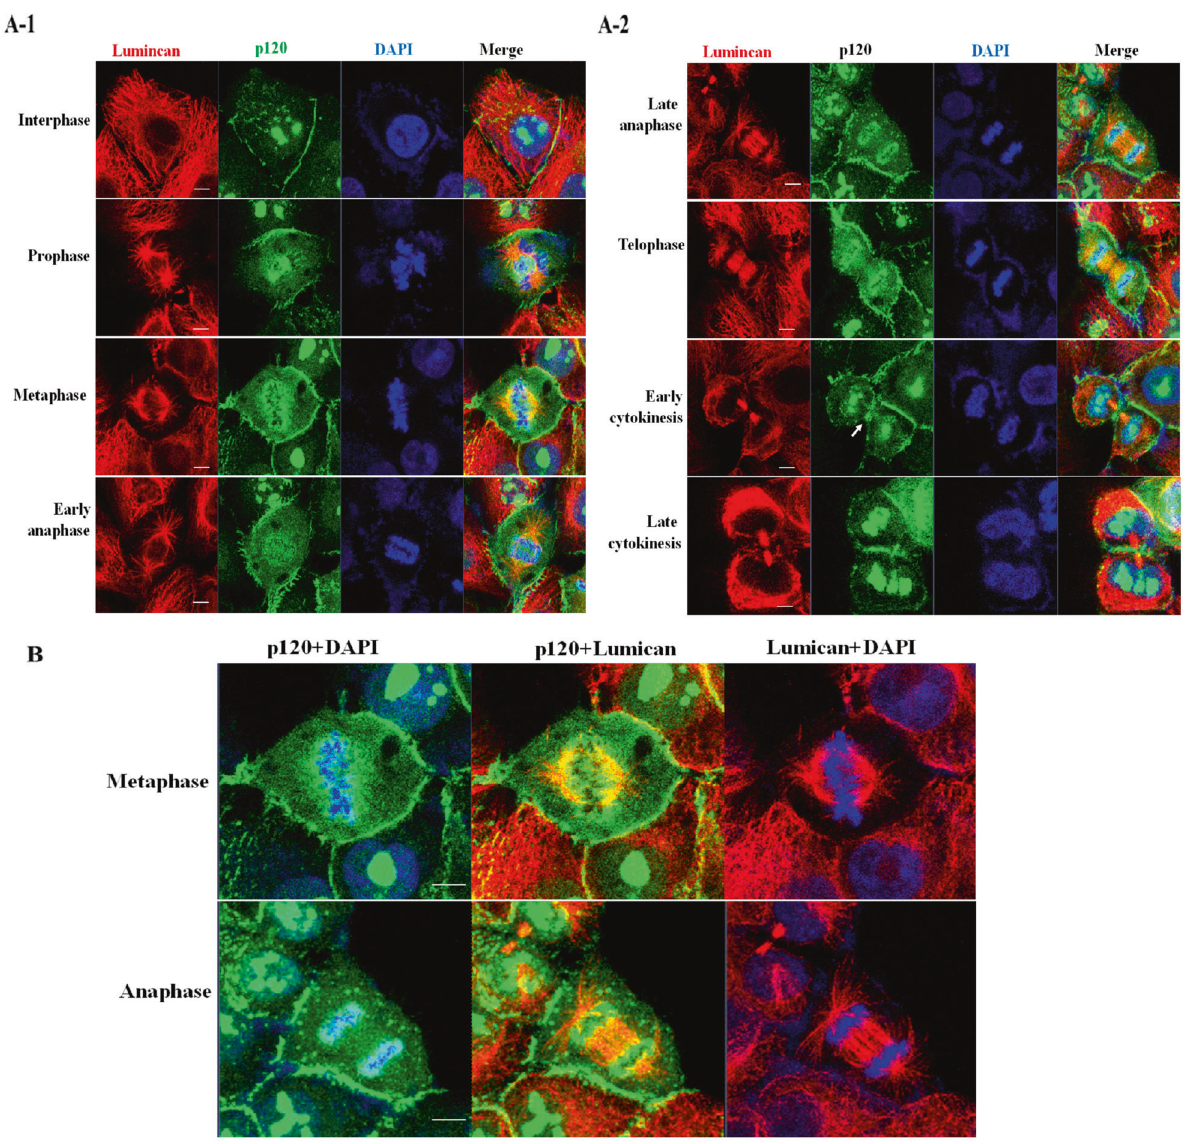
Fig. 3 P120 catenin colocalizes with lumican at the boundary of the chromosome periphery. H460 cells were immunostained using anti- lumican (red) and anti-p120 catenin (green) antibodies for 24 h. A Confocal images of cells in interphase, prophase, metaphase, and telophase (cytokinesis). B High-power merged images of p120 catenin + lumican and p120 catenin + DAPI in the cells in metaphase/anaphase are shown in ( A